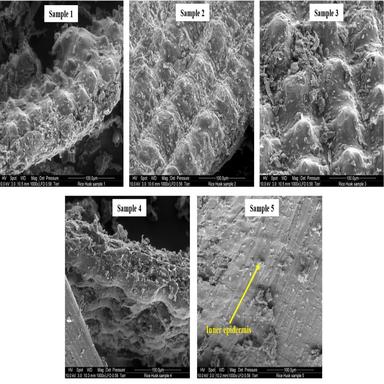
Scanning electron microscopy images of individual RH biomasses (without being integrated in the composite). Sample 1 is Pakistani rice husk, Sample 2 is round glutinous rice husk, Sample 3 is long Indica rice husk, Sample 4 is round Japonica rice husk and Sample 5 is long glutinous rice husk. The micrographs indicate the undulated outer epidermis and smooth inner epidermis of all the rice husks. (For interpretation of the references to colour in this figure legend, the reader is referred to the web version